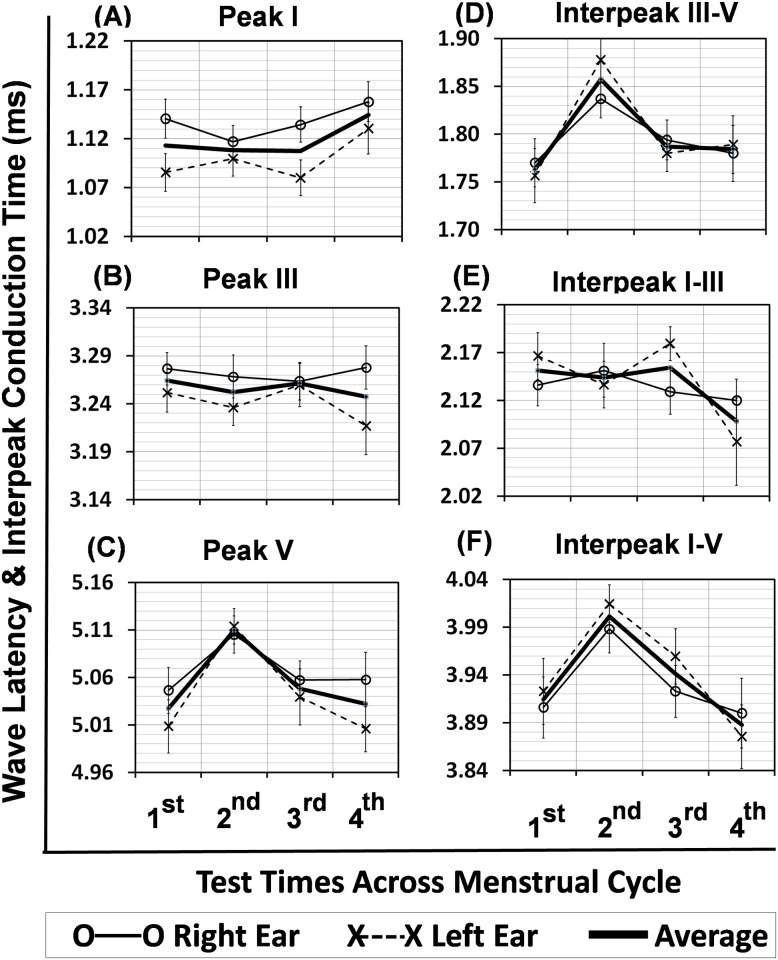
ABR wave latency and interpeak conduction time across the menstrual cycle.Error bars are standard errors.